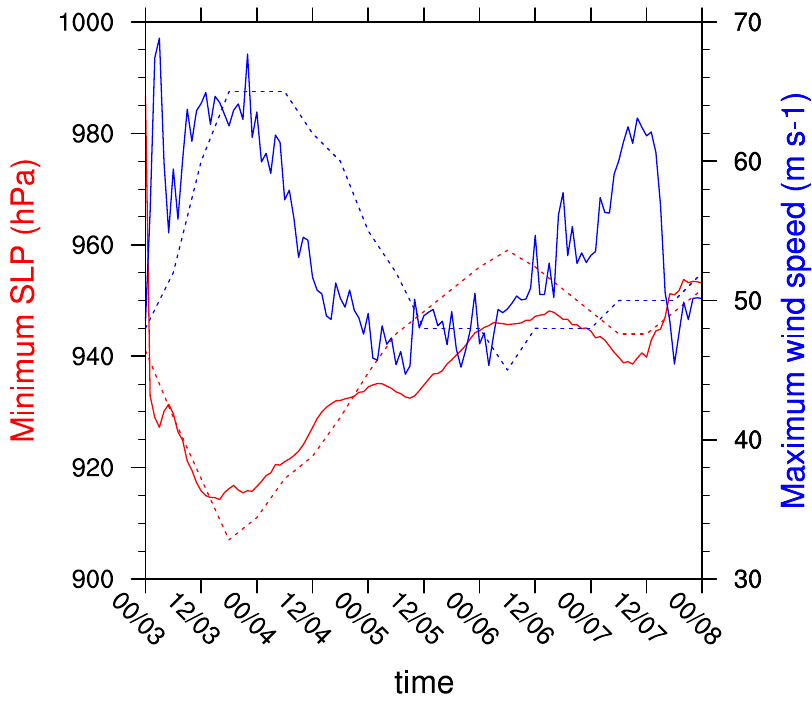
Figure 7. The evolution of maximum surface wind (blue) and minimum surface level pressure (red). Those from simulation and JWTC best track data are represented by solid and dash lines,